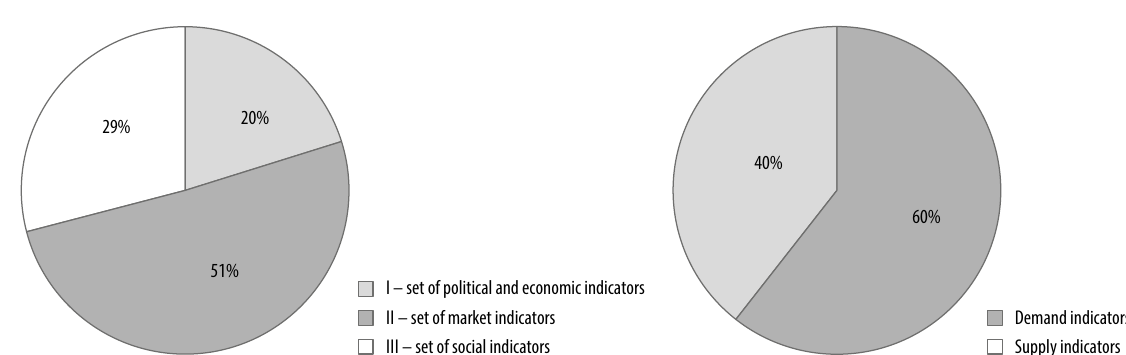
Contribution of indicators in "rating